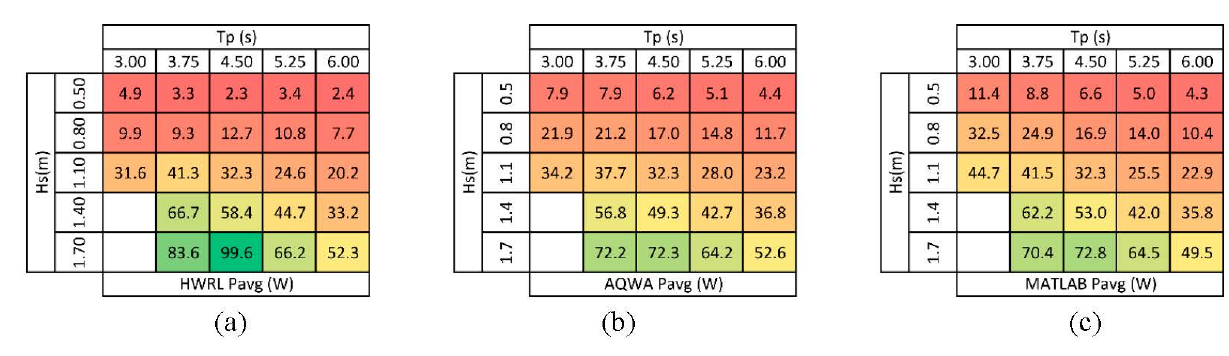
Figure 12. Power Matrix for irregular wave input: ( a ) HWRL wave tank testing; ( b ) AQWA model; and ( c ) MATLAB model. All quantities are Froude scaled to full